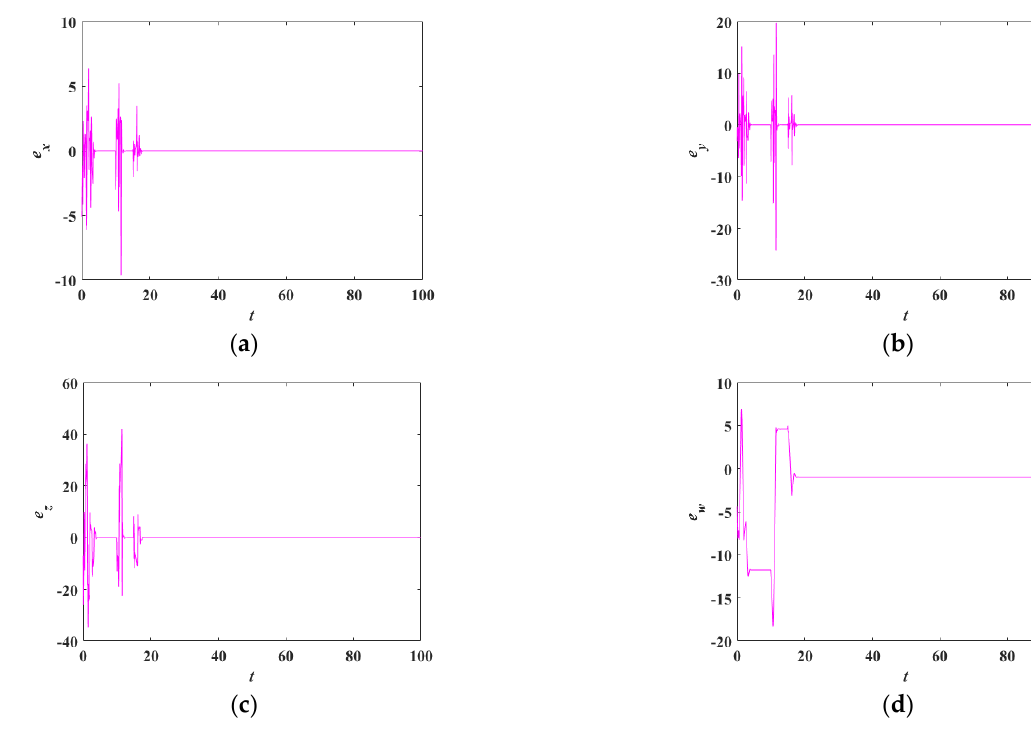
6 Algorithm 1 ( d ) Figure 4. Handling repeated values in sequence 𝑥 (cid:2903) ’ Table 1. Pseudo-code for Algorithm 1. Algorithm 1: Fill missing index values into sequence 𝑥 (cid:2903) ’ Input: 𝑥 (cid:2903) ’ , p Output: x H